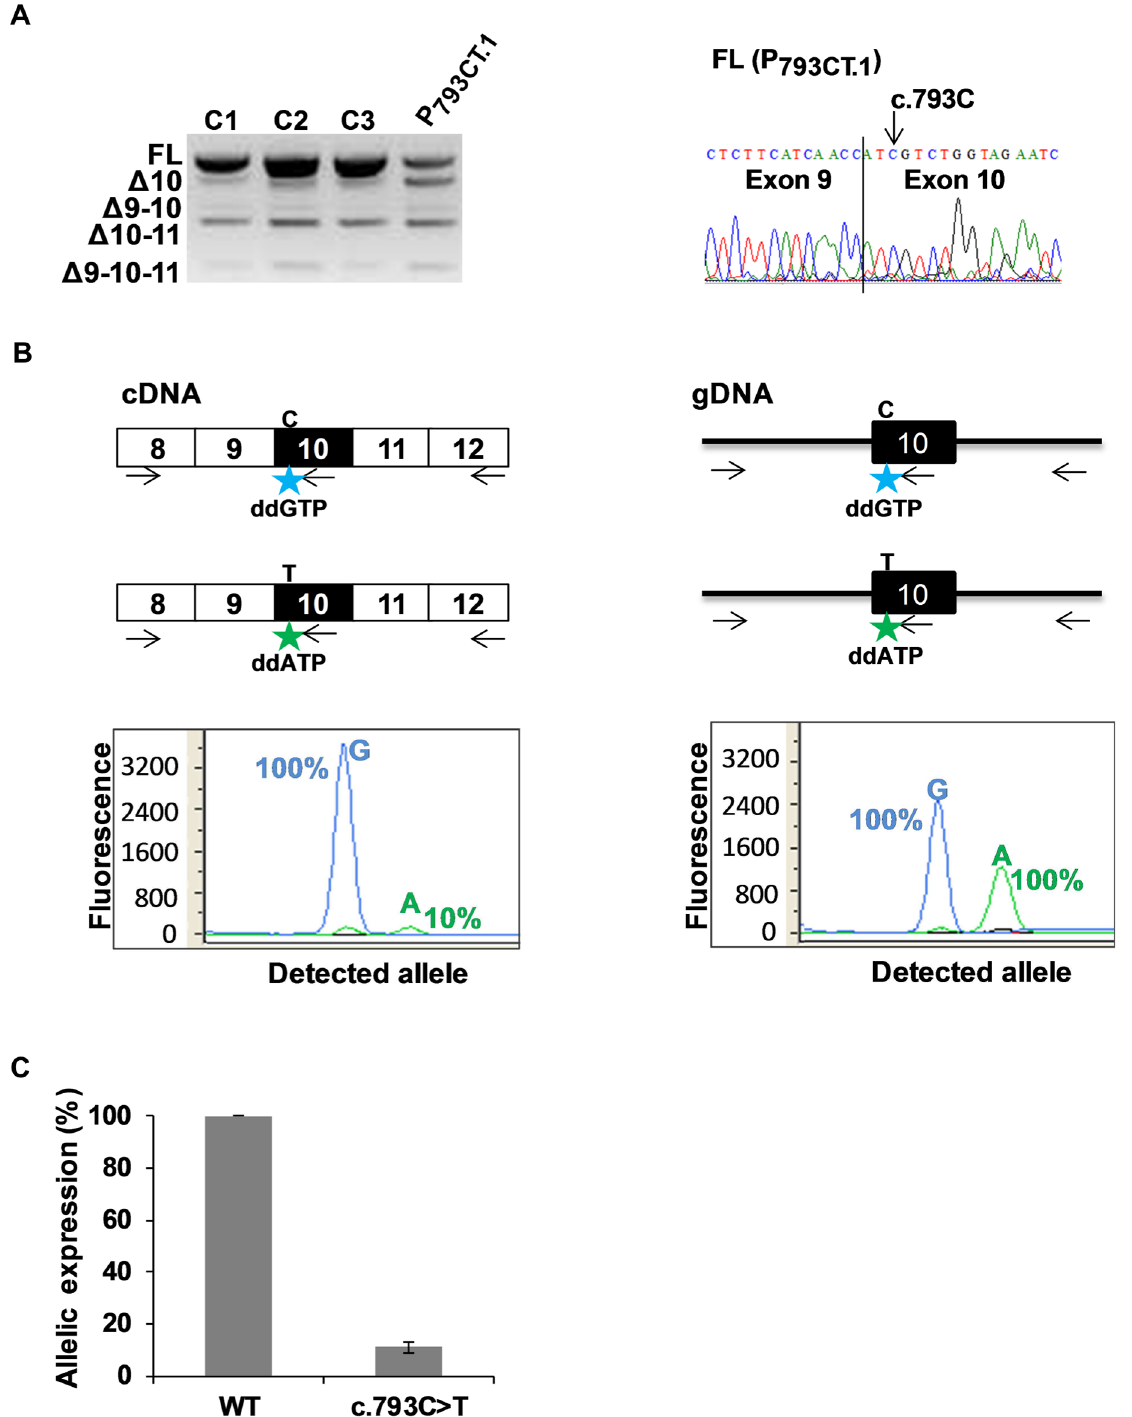
Fig 5. Detection of aberrant splicing in the blood cells of a patient carrying MLH1 c.793C > T variant. (A) Comparative RT-PCR analysis of fresh blood RNA samples obtained from 3 healthy control individuals (C1, C2 and C3) and from a patient carrying the heterozygous variant MLH1 c.793C > T (P 793CT.1 ). RT-PCR reactions were performed with primers mapping to MLH1 exon 8 (forward primer) and exon 12 (reverse primer), as described under Materials and Methods. The panel on the left shows the RT-PCR products separated on a 2% agarose gel, and is representative of 3 independent experiments. RT-PCR product identifiers are indicated on the left of the gel. The sequence on the right refers to the FL product obtained from patient P 793CT.1 , with a vertical line indicating the junction between exons 9 and 10. FL, full-length; Δ , exon skipping. (B) Allele-specific expression of MLH1 in the blood cells of patient P